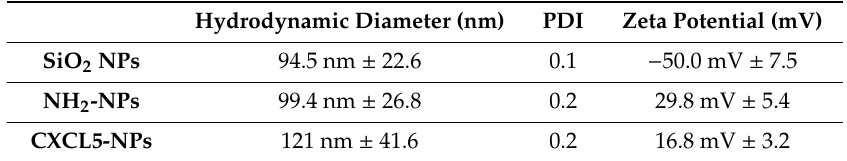
Table 1. Hydrodynamic diameter, polydispersity index (PDI), and surface charge of the di ff erent NPs.